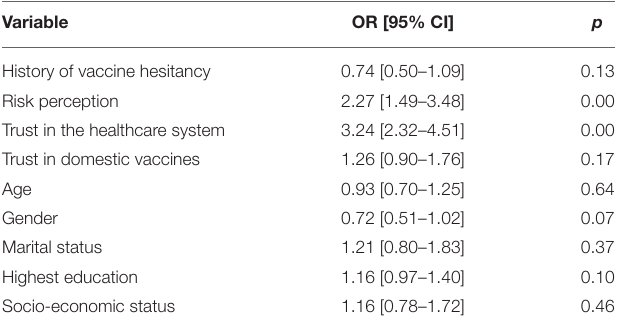
Trust in the healthcare system